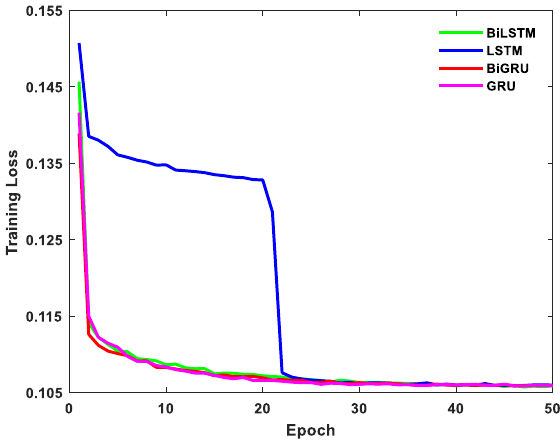
Figure 6. Training loss of BiLSTM, LSTM, BiGRU, and GRU.